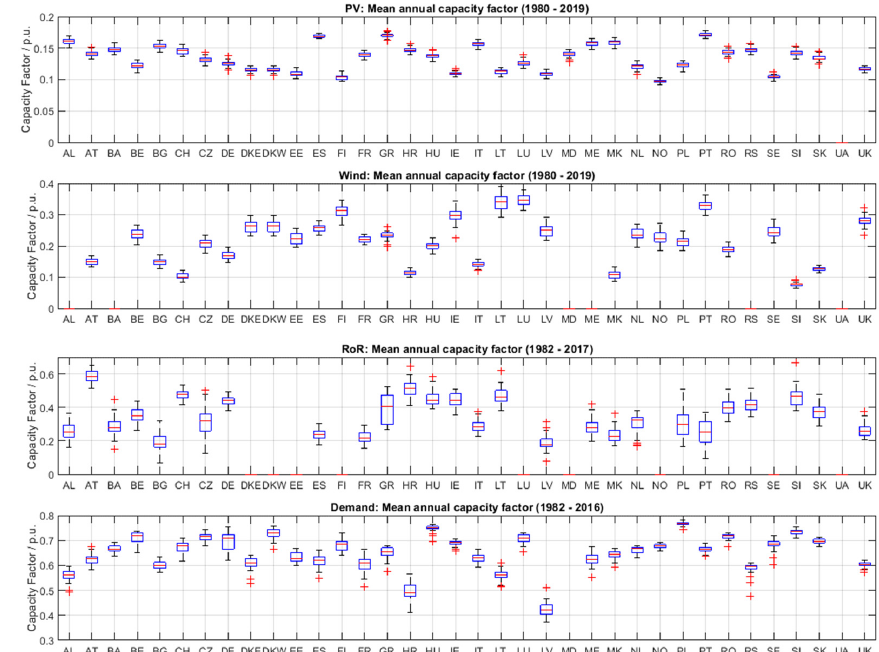
Figure 12. Variability in historical solar, wind onshore and hydro run-of-river as well as load ca- pacity